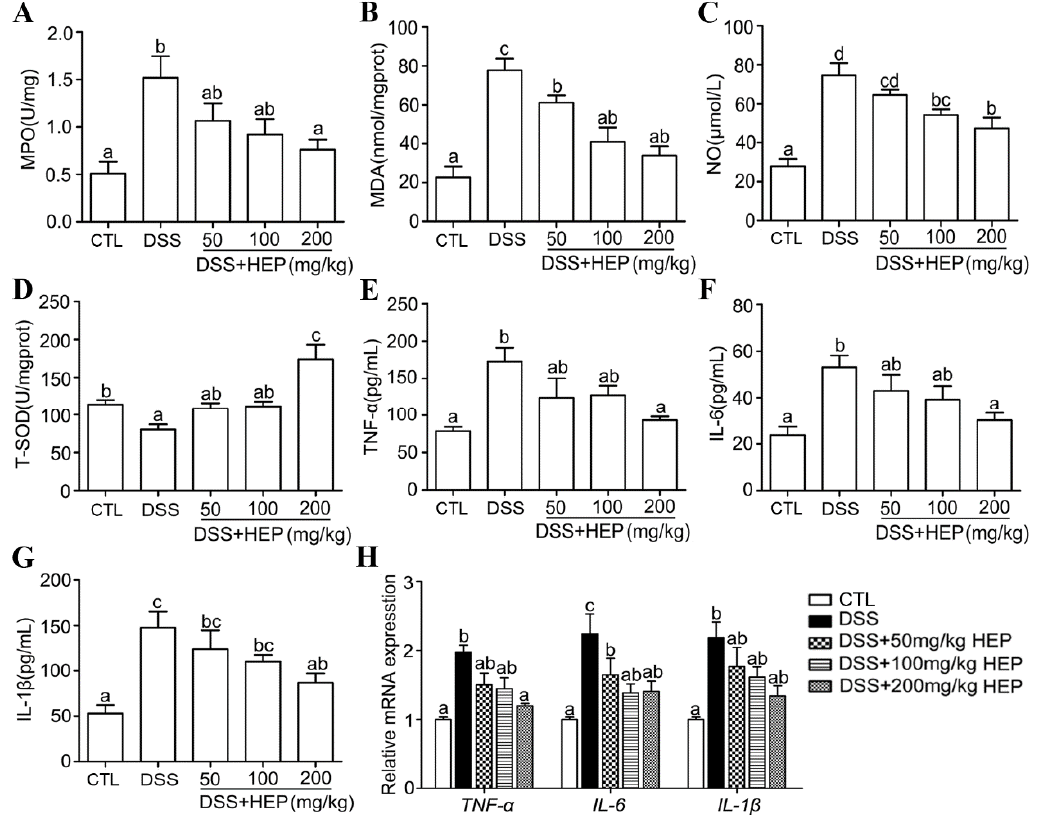
Figure 5. HEP10 inhibited inflammatory and oxidative damage on mucosa in C57BL/6 mice with DSS-induced colitis. ( A ) MPO level, ( B ) MDA level, ( C ) NO level, ( D ) T-SOD activity, ( E ) TNF- α , ( F ) IL-1 β , and ( G ) IL-6 levels in colonic content were determined by ELISA. ( H ) Relative gene expression of TNF- α , IL-1 β , and IL-6 were detected by qRT-PCR. The data is presented as means ± SD ( n = 5). Different alphabetic letters refer to significant differences ( p < 0.05, two sided).